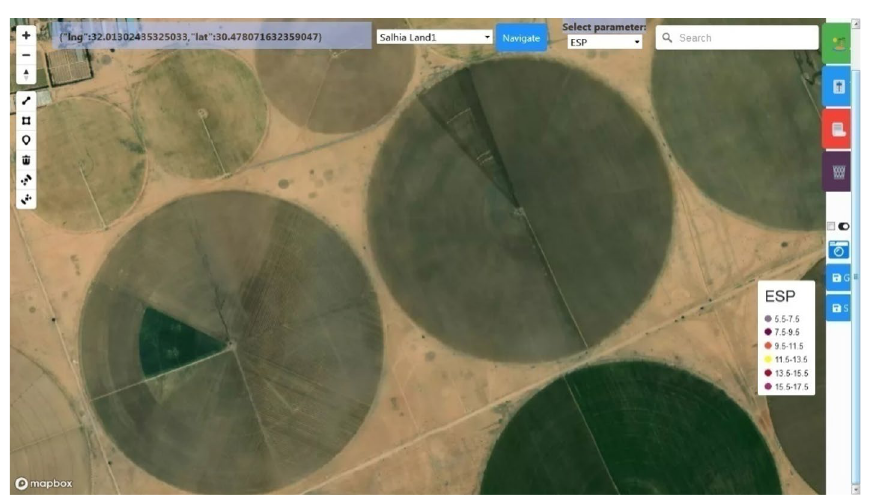
Figure 18. The two adjacent test